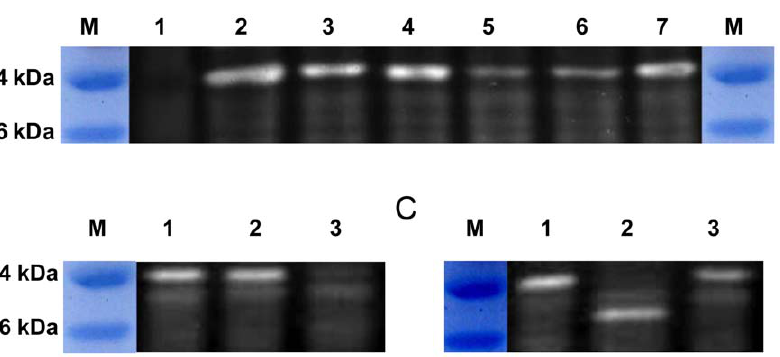
Figure 5. Western blot analysis of FlaA and FlaB. Whole-cell lysates were prepared from S. oneidensis cultures in mid-exponential growth phase, loaded equally, separated on 12% SDS-PAGE, and electrophoretically transferred to polyvinylidene difluoride (PVDF). S. oneidensis flagellins were probed with polyclonal antibodiesthat recognize both FlaA and FlaB and detected by chemiluminescence. In all panels, M represents the protein marker. The samples in each lane are the (A) 1, D flaA D flaB strain, 2, D flaB / flaB strain, 3, D fliA / fliA strain, 4, wild type strain, 5, D fliA strain, 6, D flaB strain, 7, D flaA strain; (B) 1, wild type strain, 2, D fliD / fliD strain, 3, D fliD strain; (C) 1, wild type strain, 2, D pseB strain, 3, D pseB / pseB strain.